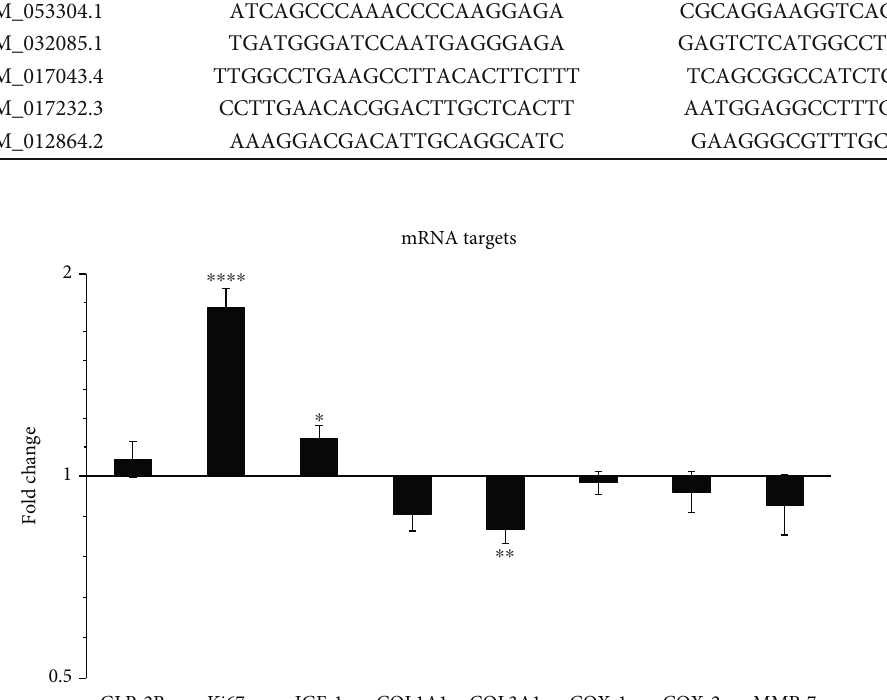
Figure 1: The e ff ect of one-day ZP1849 treatment on the gene expression in the noninjured colon on day 0. The mRNA levels were normalized to RPLP0, shown as fold changes relative to vehicle-treated rats and tested as ZP1849 versus vehicle. ∗ P < 0 : 05 , ∗∗ P < 0 : 01 , and ∗∗∗∗ P < 0 : 0001 . Geometric mean ± back ‐ transformedSEM